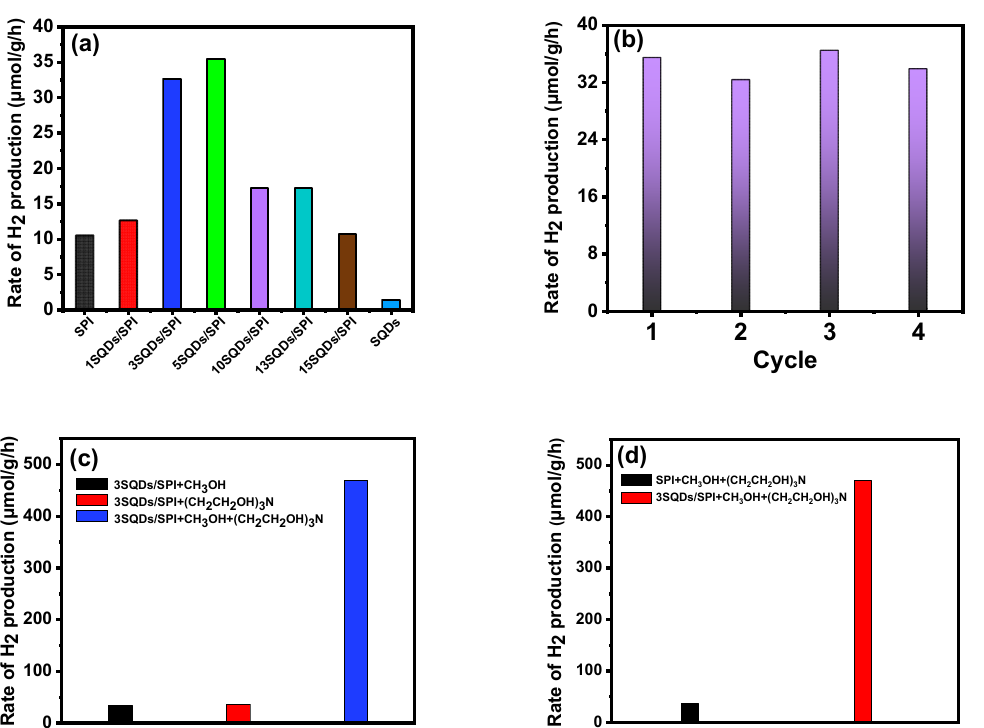
Figure 6. H 2 production of ( a ) SPI, SQDs, and SQDs/SPI composites. ( b ) recyclability testing of 5SQDs/SPI. ( c ) 3SQDs/SPI in different aqueous solutions of hole sacrificial agents. ( d ) SPI and 3SQDs/SPI samples in aqueous solutions of CH 3 OH and (CH 2 CH 2 OH) 3 N as hole sacrificial agents under simulates sunlight irradiation.